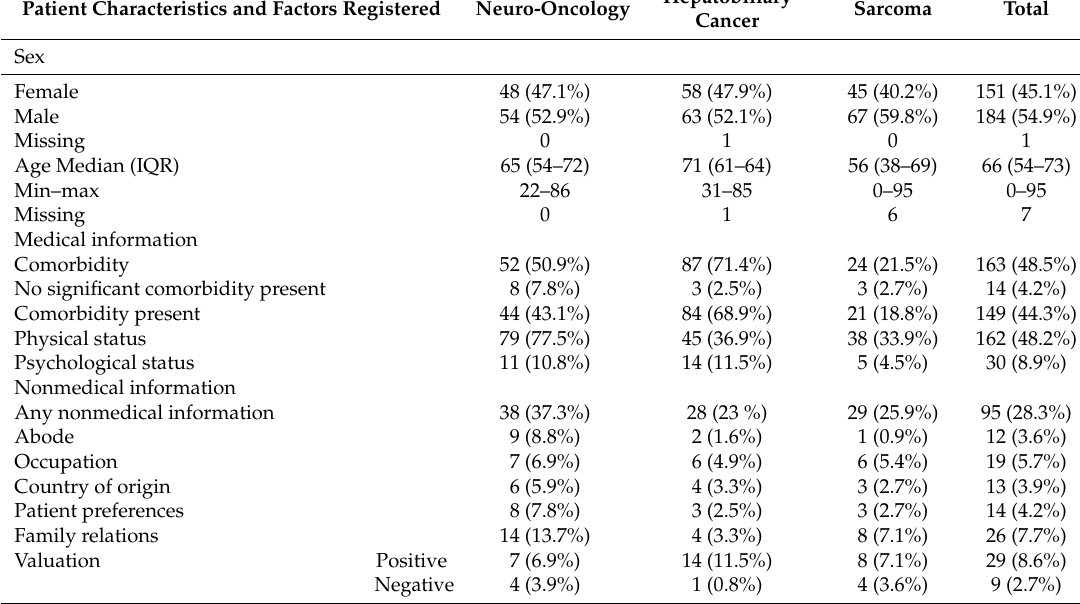
Table 1. Summary of information on medical and nonmedical information